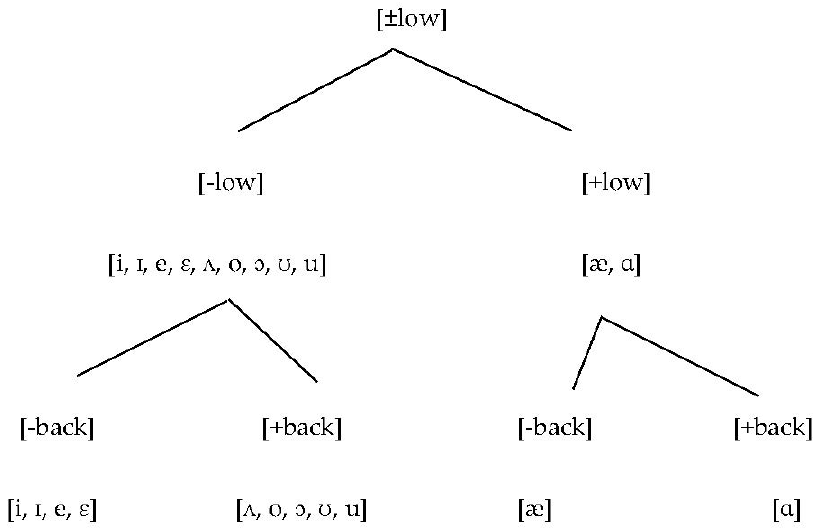
Figure 10. The Arabic contrastive hierarchy applied to English vowels.